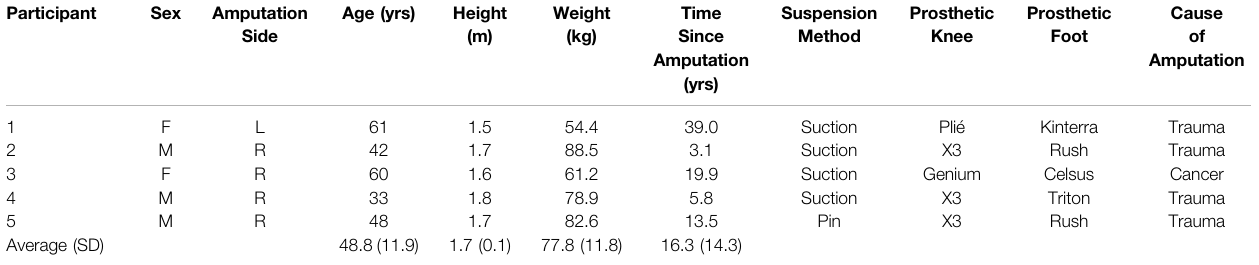
TABLE 1 | Participant Demographics.